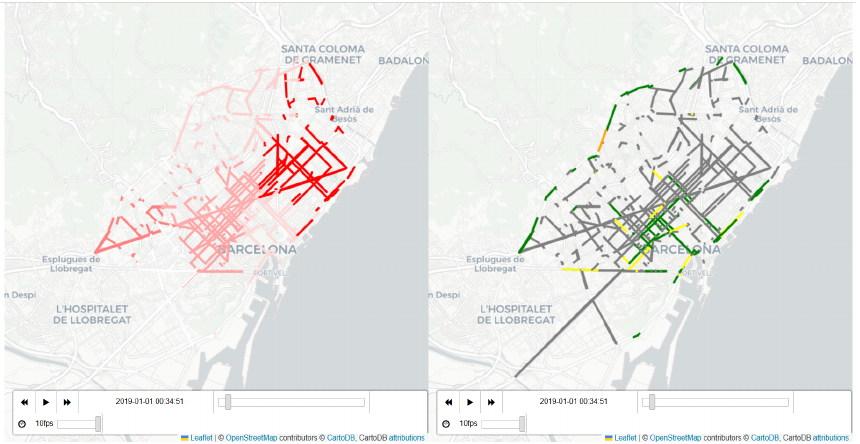
Figure 6. Dashboard for interactivemaps and visualizations. ( Right ) NO 2 Pollution rates ( µ g/m 3 ). ( Left ) Traffic Density (scalar